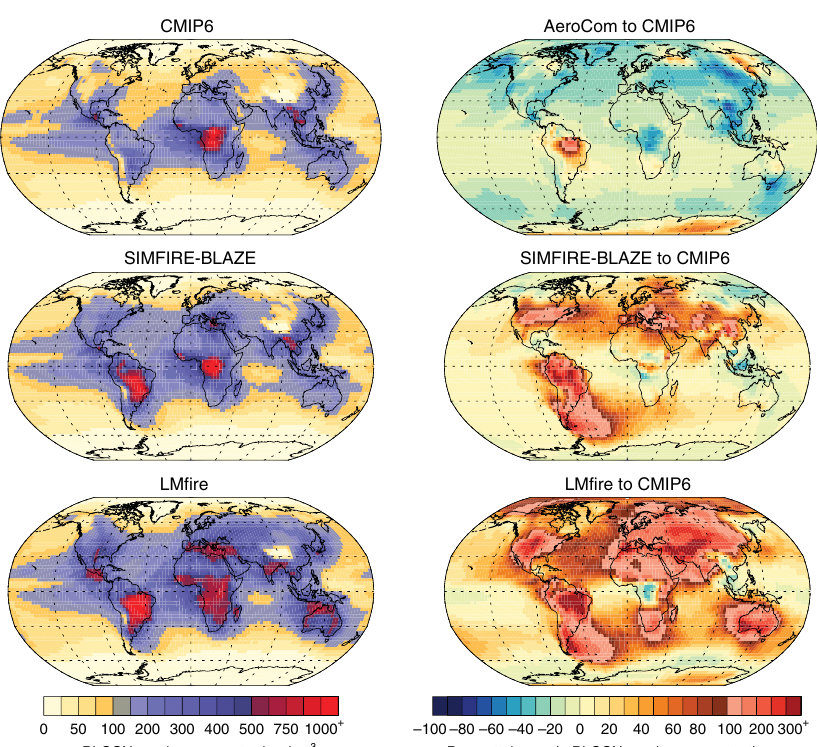
Fig. 3 Pre-industrial cloud condensation nuclei concentrations. Annual mean pre-industrial cloud condensation nuclei (CCN) concentrations (cm − 3 ) for the three main PI fi re emission datasets (LM fi re, SIMFIRE-BLAZE and CMIP6), and the percent change in the AeroCom, SIMFIRE-BLAZE and LM fi re fi re emission estimates compared to the CMIP6 dataset. CCN number concentrations are calculated at a supersaturation of 0.2% at 915 hPa (approximately cloud base for warm shallow, radiatively important